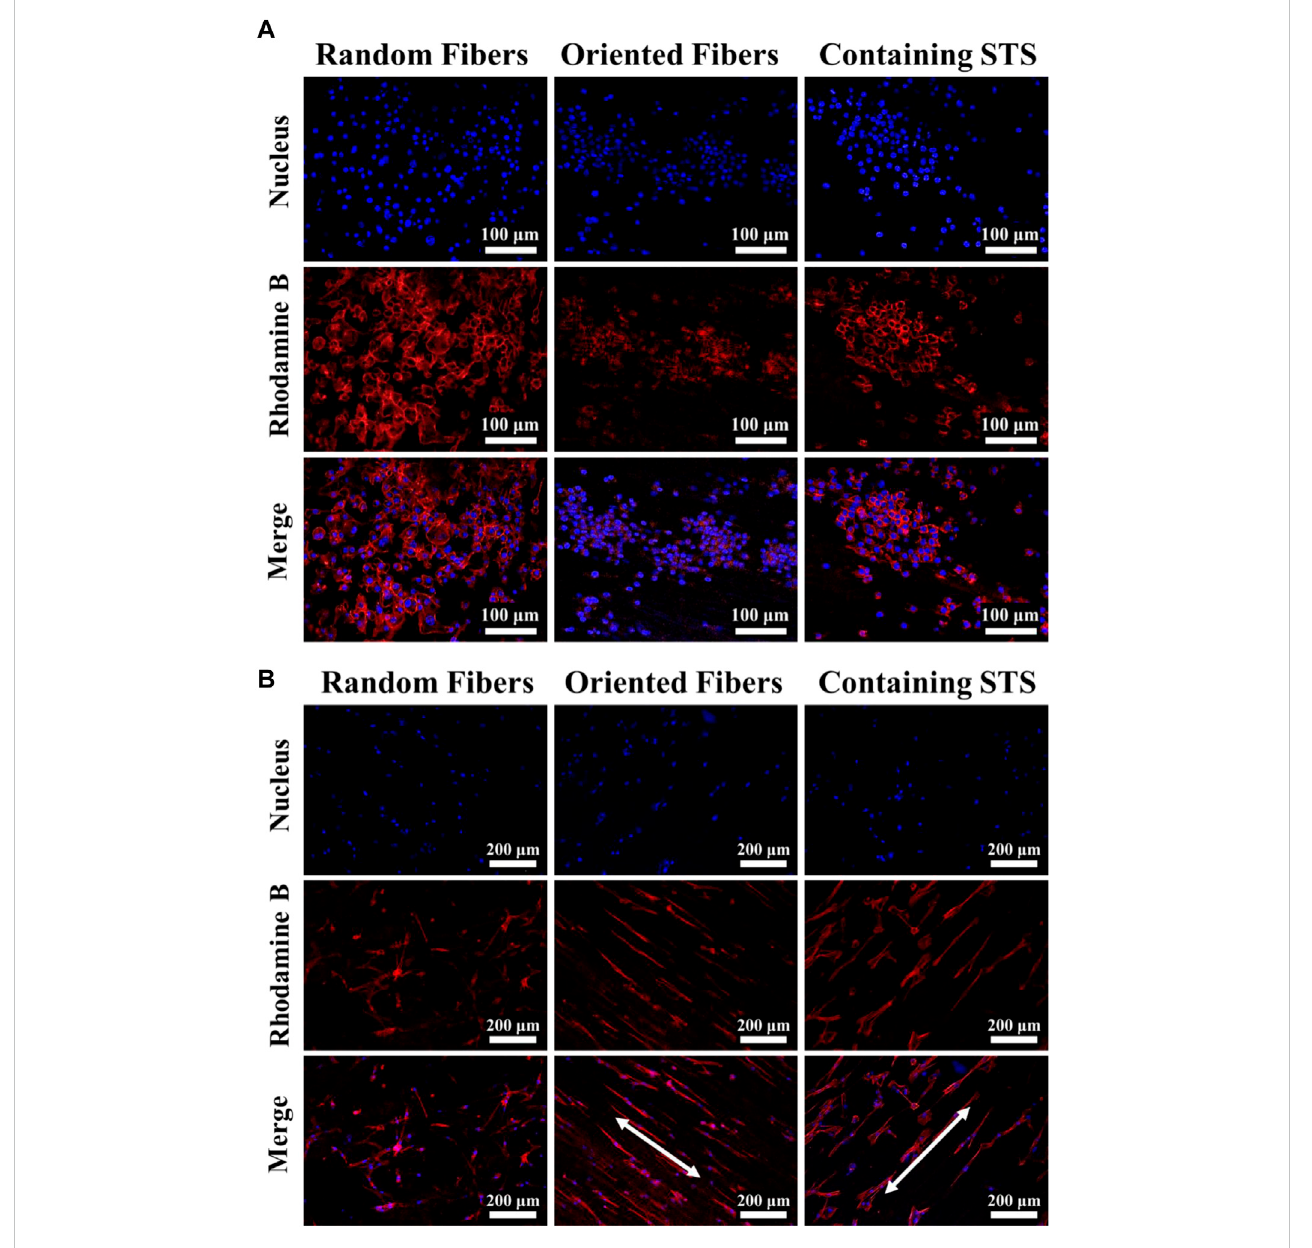
FIGURE 8 Morphologies of (A) RAW264.7 and (B) HUASMCs under laser scanning confocal microscopy on random- fi ber membranes, oriented- fi ber membranes, and oriented- fi ber membranes containing